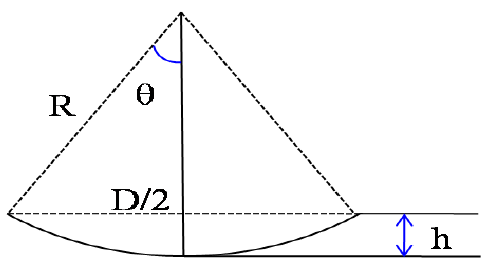
Figure 1. Schema of the substrate surface.